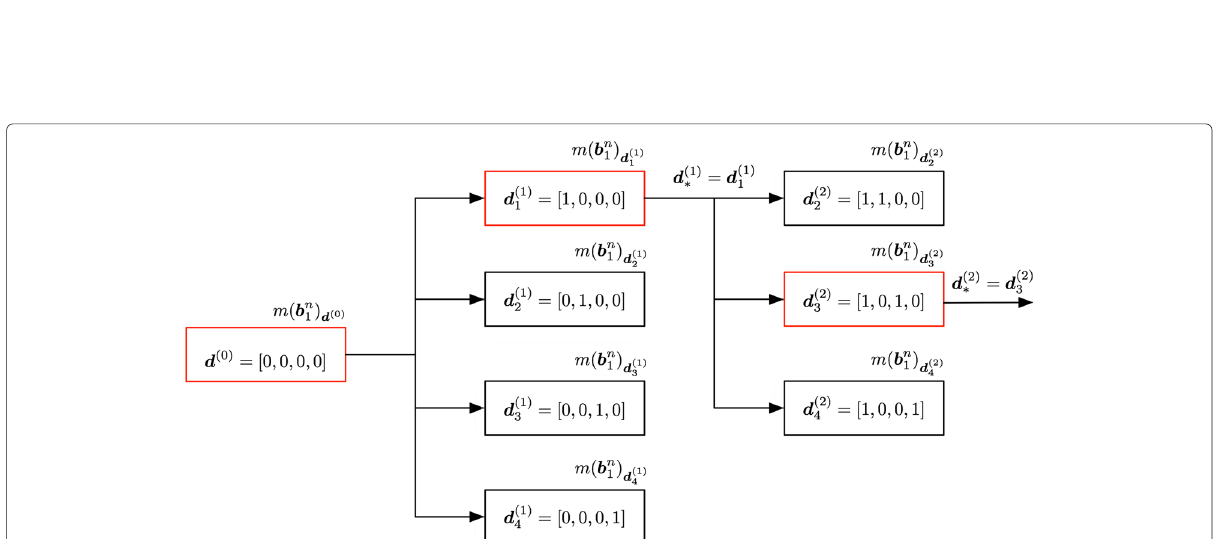
Fig. 4 An example of channel sparsity estimation using the MA. A length-4 channel with two active taps: h = [ h 0 ,0, h 1 ,0] is used. The red boxes show the sparsity vectors identified as best at each iteration of the